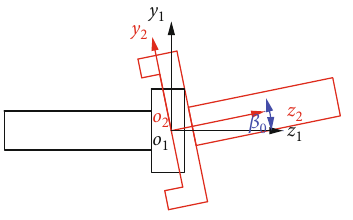
Figure 3: Diagram of the angular misalignment.